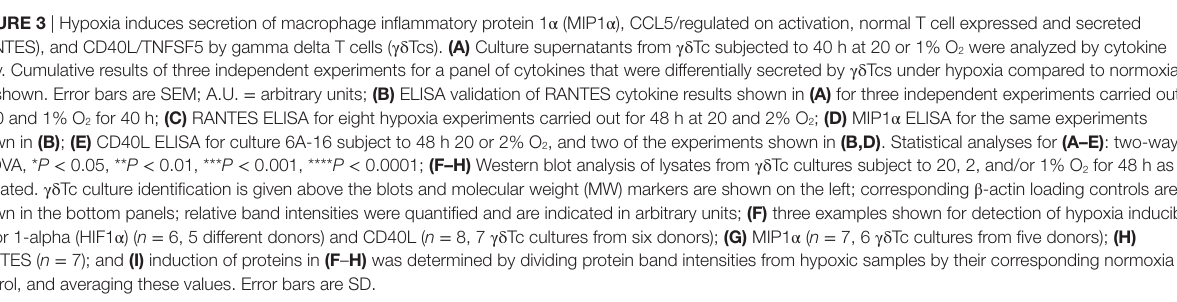
FigUre 3 | Hypoxia induces secretion of macrophage inflammatory protein 1 α (MIP1 α ), CCL5/regulated on activation, normal T cell expressed and secreted (RANTES), and CD40L/TNFSF5 by gamma delta T cells ( γδ Tcs). (a) Culture supernatants from γδ Tc subjected to 40 h at 20 or 1% O 2 were analyzed by cytokine array. Cumulative results of three independent experiments for a panel of cytokines that were differentially secreted by γδ Tcs under hypoxia compared to normoxia are shown. Error bars are SEM; A.U. = arbitrary units; (B) ELISA validation of RANTES cytokine results shown in (a) for three independent experiments carried out at 20 and 1% O 2 for 40 h; (c) RANTES ELISA for eight hypoxia experiments carried out for 48 h at 20 and 2% O 2 ; (D) MIP1 α ELISA for the same experiments shown in (B) ; (e) CD40L ELISA for culture 6A-16 subject to 48 h 20 or 2% O 2 , and two of the experiments shown in (B,D) . Statistical analyses for (a–e) : two-way ANOVA, * P < 0.05, ** P < 0.01, *** P < 0.001, **** P < 0.0001; (F–h) Western blot analysis of lysates from γδ Tc cultures subject to 20, 2, and/or 1% O 2 for 48 h as indicated. γδ Tc culture identification is given above the blots and molecular weight (MW) markers are shown on the left; corresponding β -actin loading controls are shown in the bottom panels; relative band intensities were quantified and are indicated in arbitrary units; (F) three examples shown for detection of hypoxia